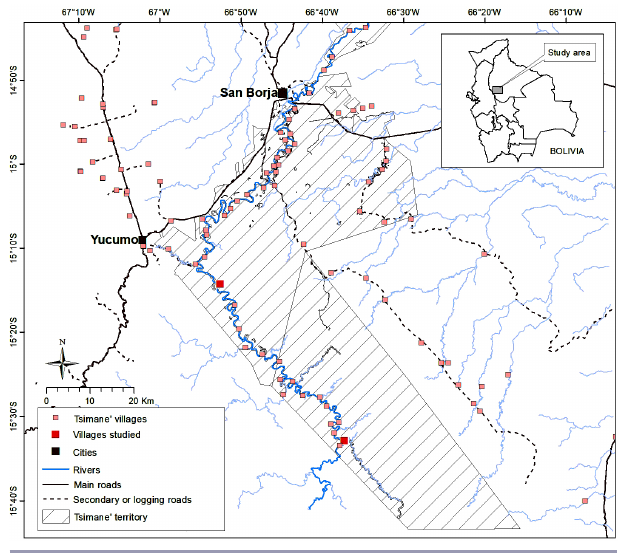
Fig. 1. Map of the study area in Amazonian